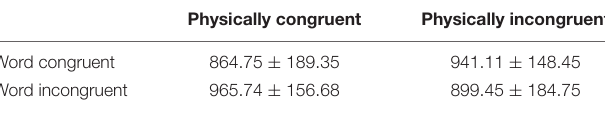
TABLE 2 | Response time (ms) of magnitude judgment task ( M ± SD